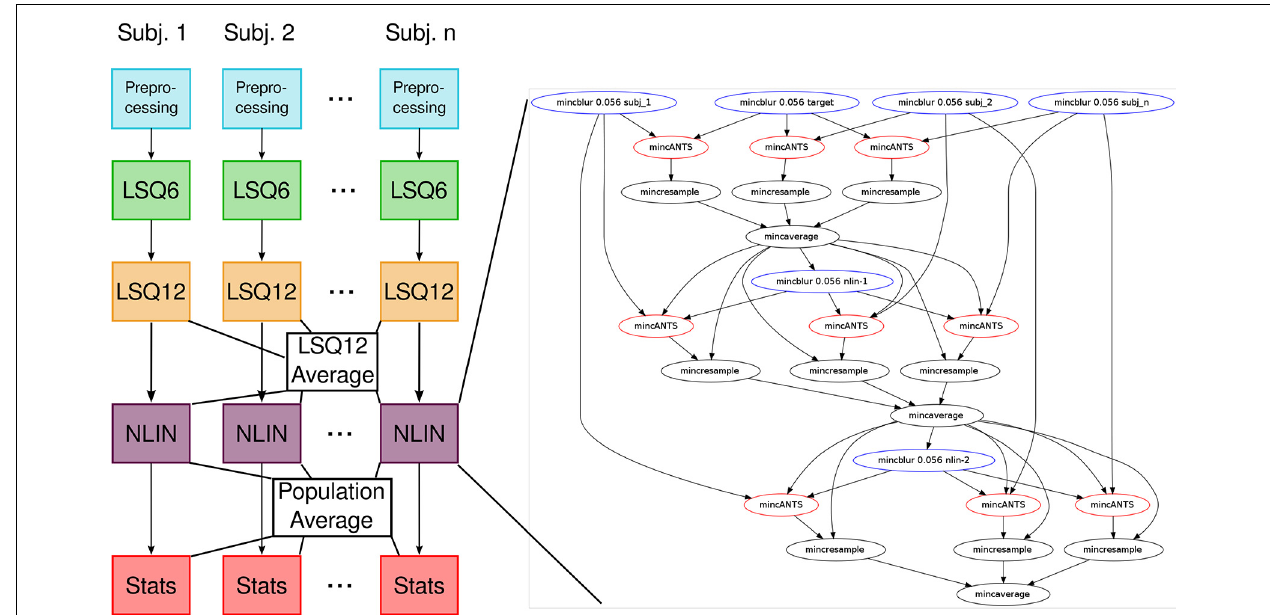
FIGURE 8 | Code diagram to complement Figures 7, 9. This figure illustrates the modular nature of how Pydpiper executes each of the stages in this pipeline. Diagramatically, each of the code blocks